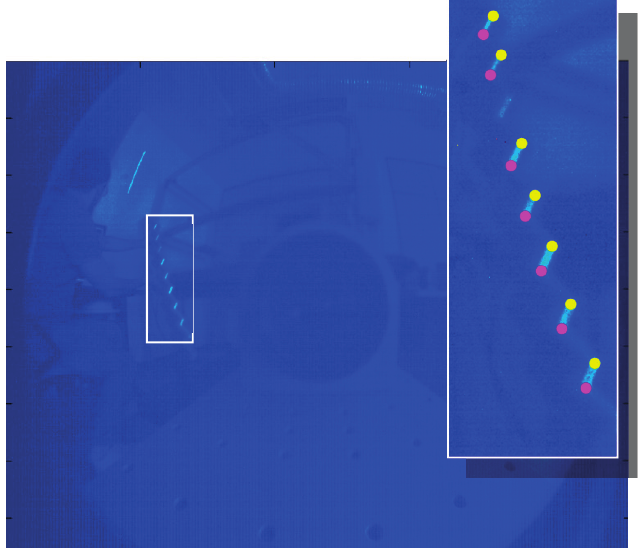
Figure 9. Example of a frame captured by the camera during the setup calibration. The laser line illuminates a target of completely known geometry. The inset highlights the extracted points belonging to the structure edges, whose distance corresponds to the thickness of the wood strips.